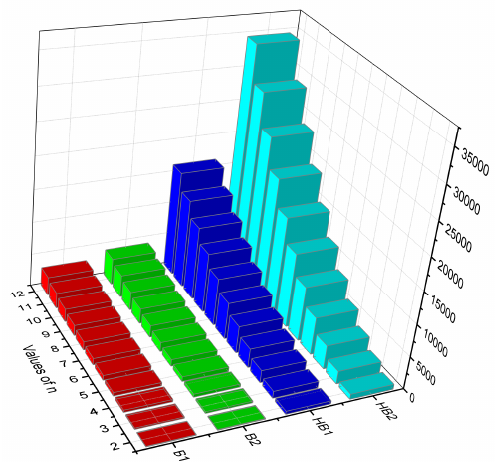
Figure 2. Graphical representation of K -Banhatti indices of PY n .